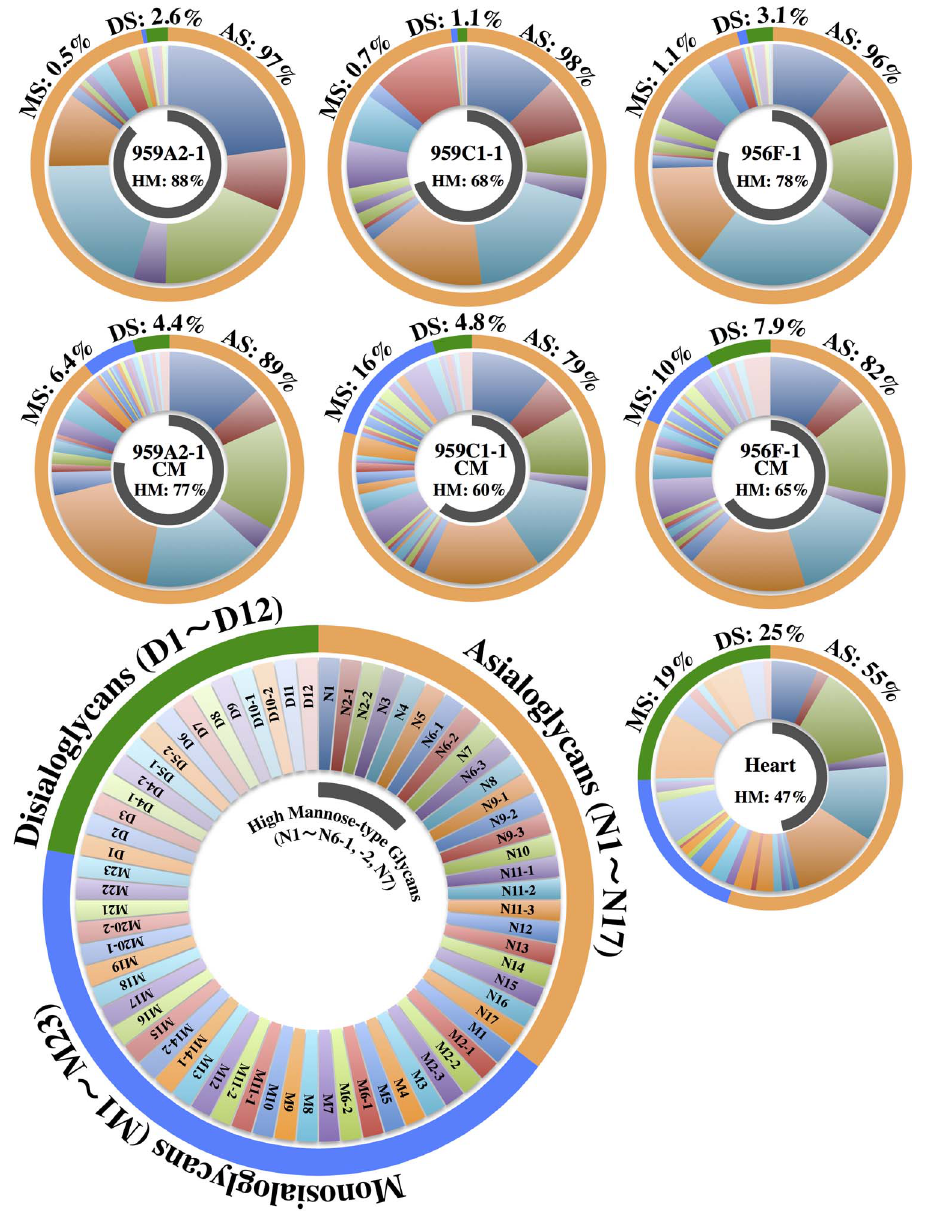
Figure 9. Relative quantities of neutral, monosialyl, and disialyl PA-oligosaccharides in iPSCs, iPSC-CM, and heart cells. Relative quantities of each glycan, calculated from the peak area in Figure 5, 6 and 7 vs. total N -glycan content in each cell, were expressed in the doughnut charts. Relative quantities of the asialoglycans, the monosialoglycans and the disialoglycans were showed outside of the charts, and relative quantities of the high mannose type glycans were showed inside of the charts. Asialoglycan (AS): the total volume of N1-N17; Monosialoglycan (MS): the total volume of M1-M23; Disialoglycan (DS): the total volume of D1-D12, High mannose-type glycan (HM): the total volume of N1–N6-1, N6-2, N7.